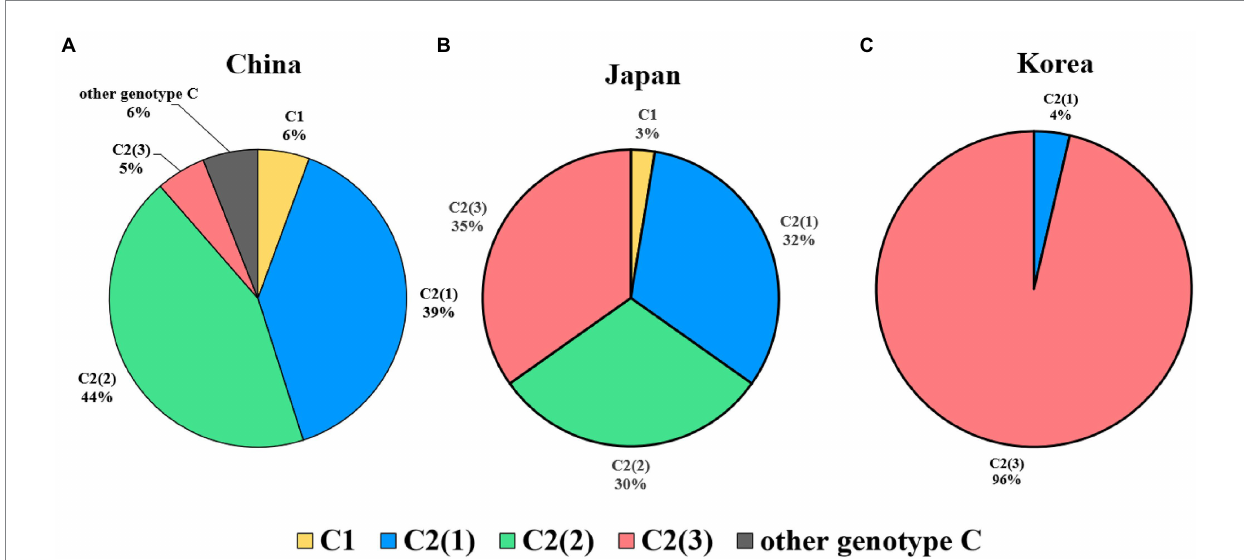
FIGURE 4 Global prevalence of three clades within hepatitis B virus subgenotype C2. (A) In China, C2(2) is the most prevalent genotype, followed by C2(1). (B) In Japan, the three subgenotypes are distributed at approximately 30%. (C) In Korea, the subgenotype C2(3) is overwhelmingly dominant and shows lower genotypic diversity than in the other two